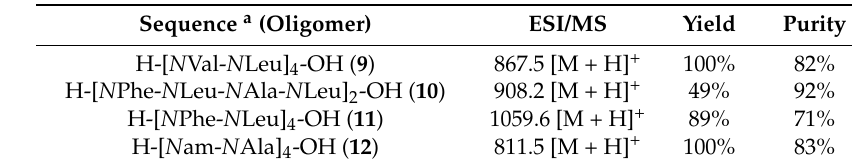
Table 1. Solid-phase synthesis of linear peptoids 9 – 12 : sequences, mass data (ESI/MS), chemical yields and purity.